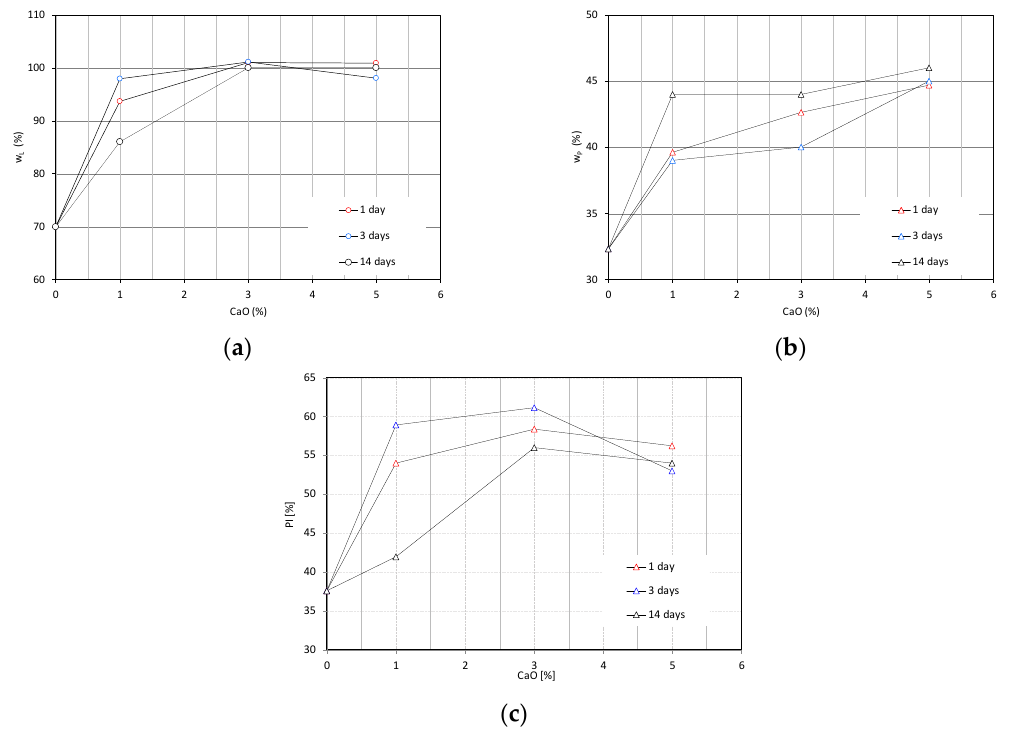
Figure 3. Changes of the plasticity properties of lime-treated kaolin as a function of the lime content and curing time: ( a ) liquid limit (w L ), ( b ) plastic limit (w P ), and ( c ) plasticity index (PI).